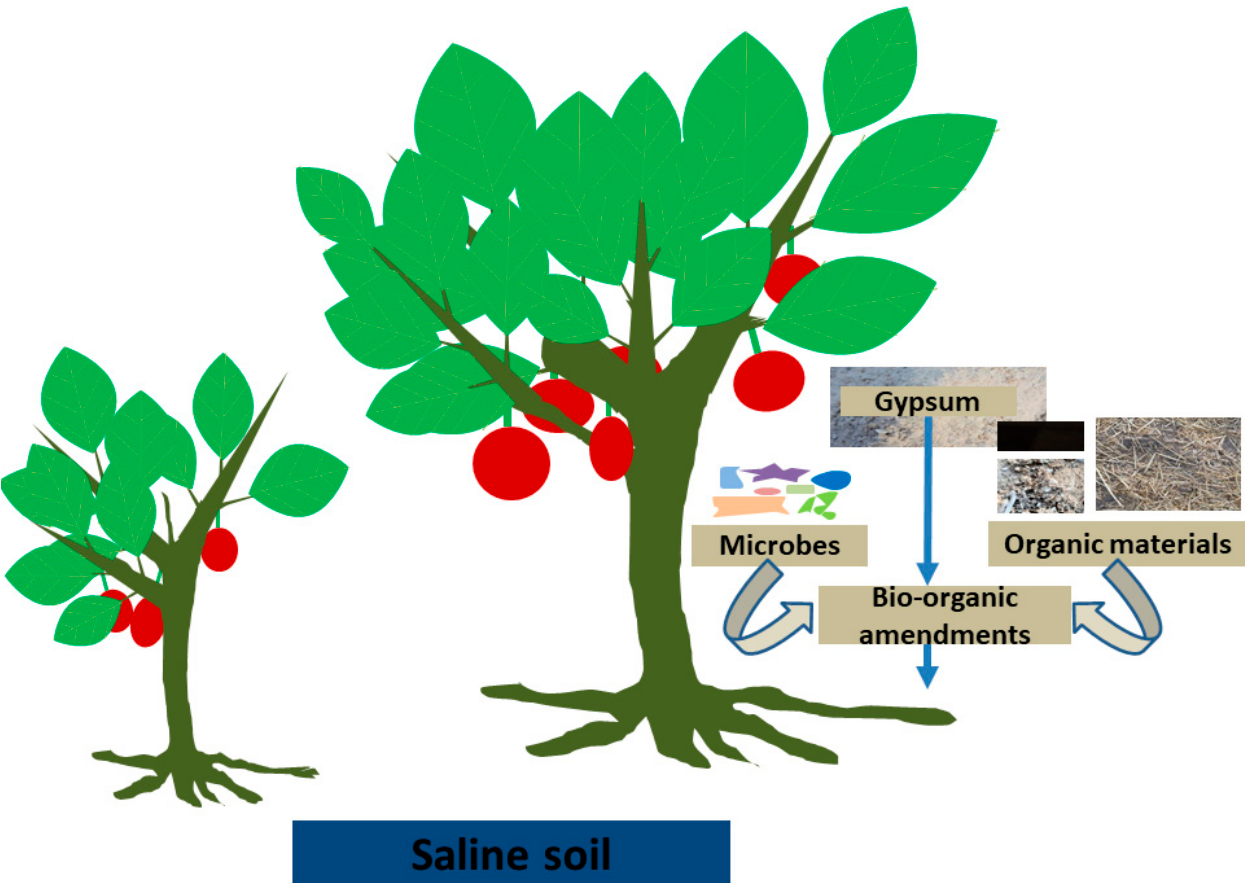
Figure 3. A hypothetical diagram depicting the potential influence of the integrated use of gypsum and bio-organic amendments on crop production.